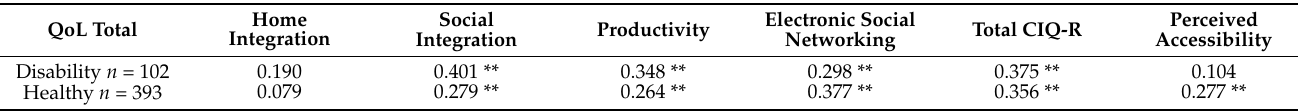
Table 3. Correlations between quality of life, accessibility, and participation in the community by